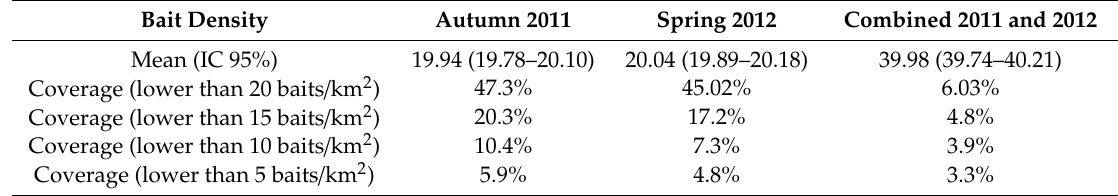
Table 1. Descriptive statistics for estimated rabies bait density (number of baits / km 2 ) in